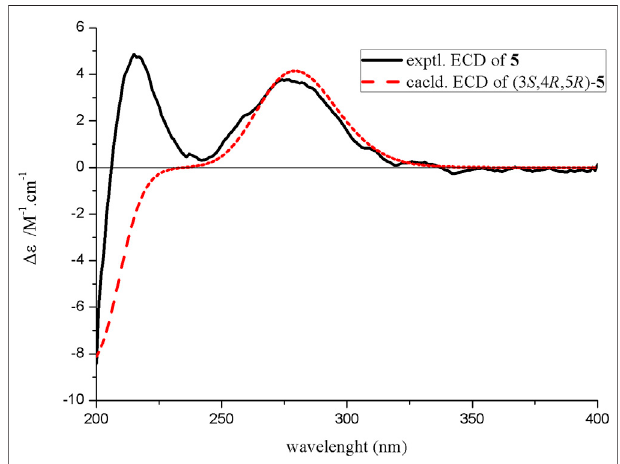
FIGURE 5 | Experimental and calculated ECD spectra of compound 5 .